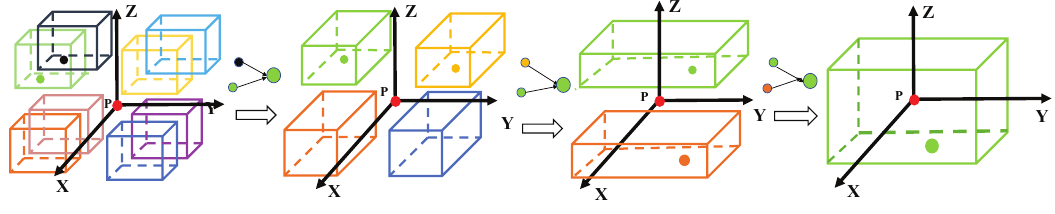
Figure 3. The details of multi-directional